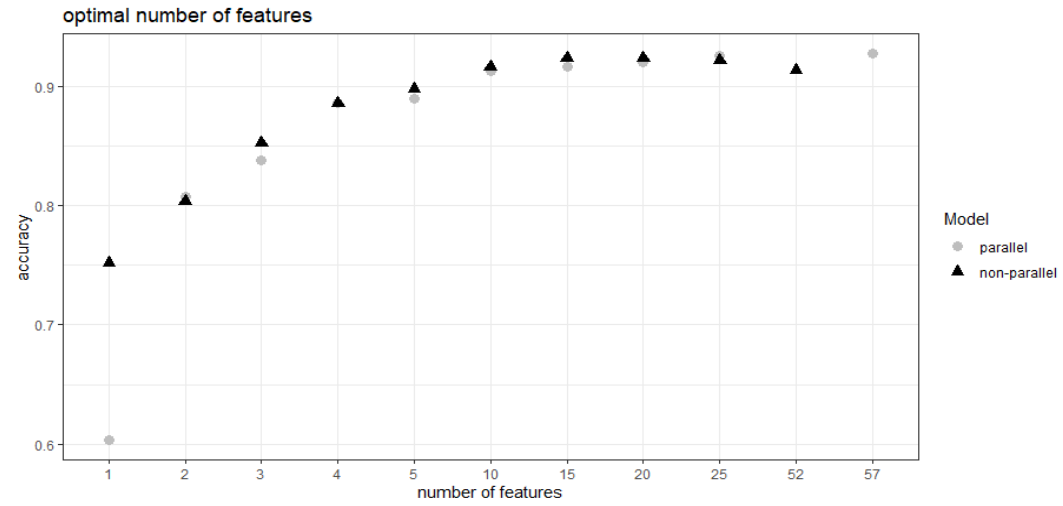
Figure A1. Optimal number of features for the parallel and non-parallel model.